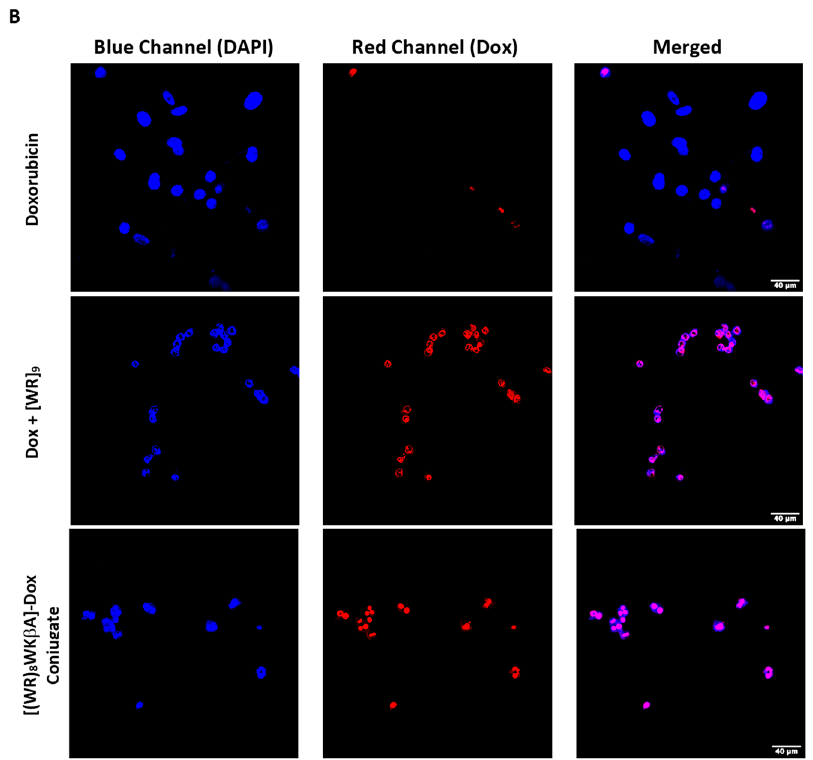
Figure 3. Confocal microscopy images of free Dox (5 µ M), [WR] 9 + Dox (1:1, (5 µ M)), or [(WR) 8 WK β A]-Dox conjugate (5 µ M) after 24 h in ( A ) MDA-MB-231 and ( B ) MES-SA/MX2 cells. Red represents the fluorescence of Dox.